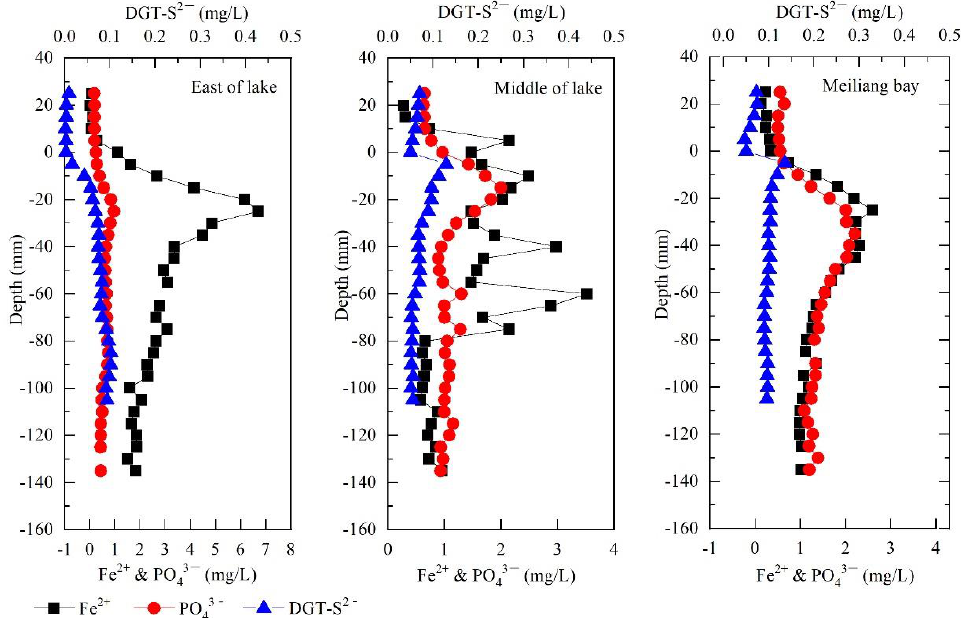
Figure 5. Concentrations of PO 43 − , Fe 2+ in the profile of pore water and DGT-S 2 − in the profile of sediment of Taihu Lake.